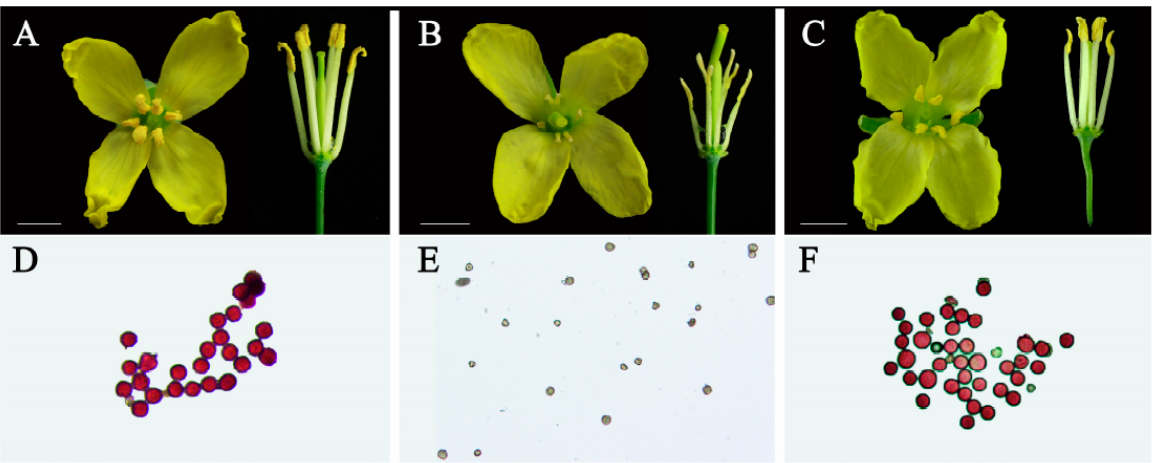
Figure 1. Flower morphology and pollen viability of the maintainer line, Ogura CMS line, and restorer line. ( A , D ) Maintainer line 19–616. ( B , E ) Ogura CMS 19–2167. ( C , F ) Restorer line FR2202. Bar = 0.5 cm.